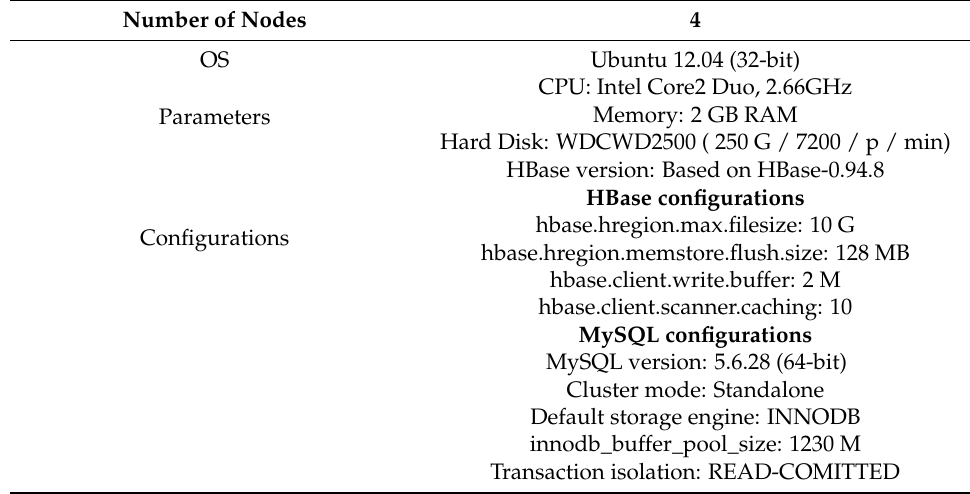
Table 2. Configurations of the